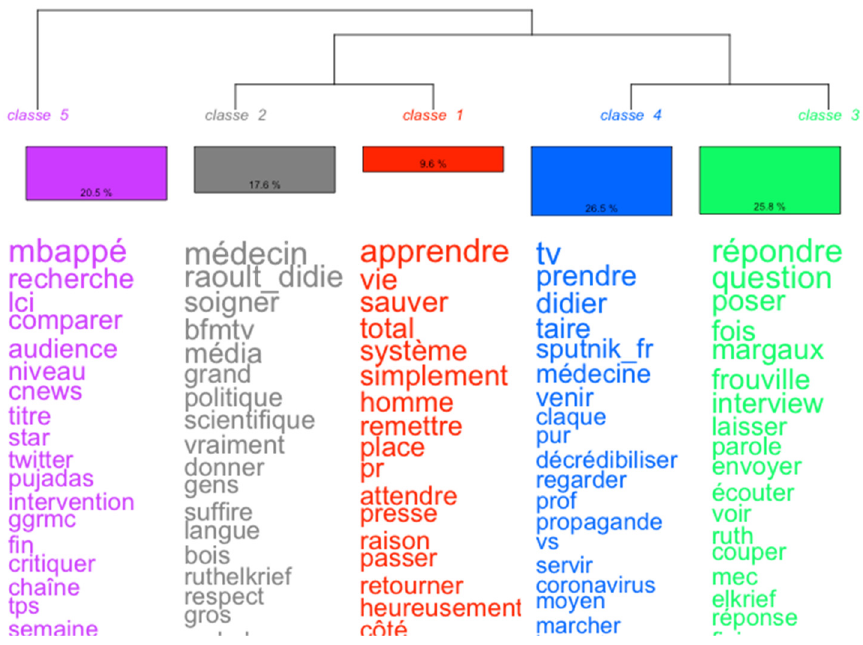
Figure 2. HDC of the corpus of